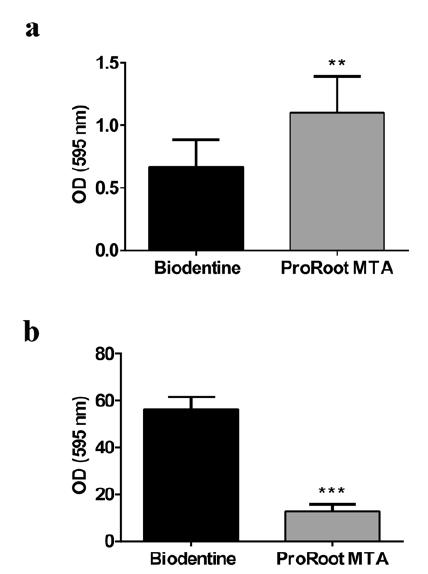
Figure 9. Evaluation of S. mutans biofilm formation on Biodentine and ProRoot MTA surface samples. Biofilm growth was evaluated by CV assay after ( a ) 4 h and ( b ) 24 h of anaerobic incubation at 37 ◦ C. Statistical analysis was carried out using Student’s t test. Error bars indicate SD and asterisks indicate statistical significance (** p < 0.01 and *** p < 0.001).